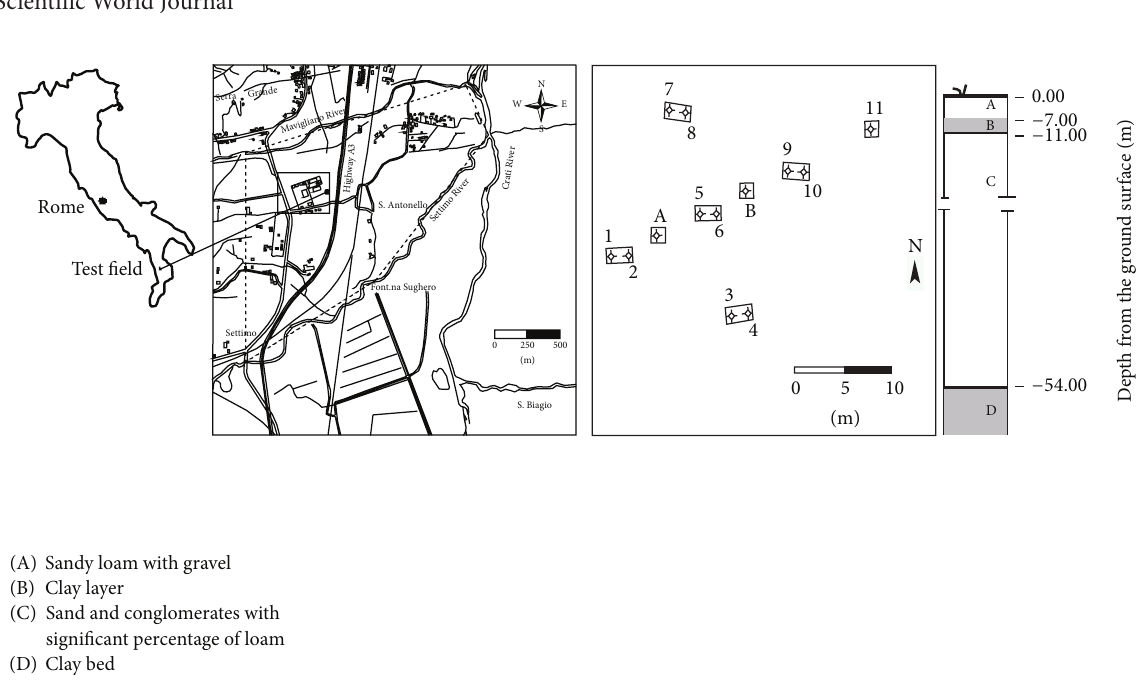
Figure 1: Planimetrical schematization of the test field. Even numbers show the wells relative to the shallow aquifer, odd numbers show the wells and A and B, the piezometers relative to the confined aquifer. Table 1: Identification number, depth from the ground level, and screen length of each well and piezometer relative to the confined aquifer of the test field. Wells